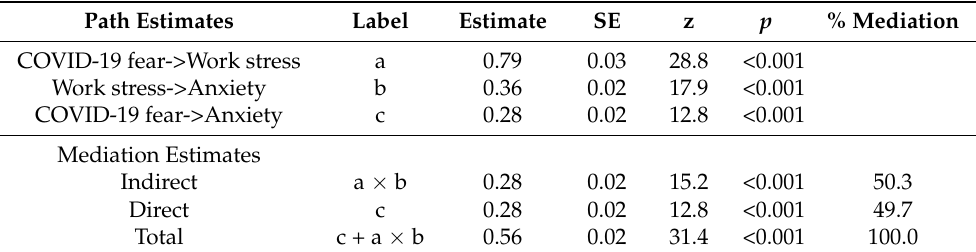
Table 5. Mediation